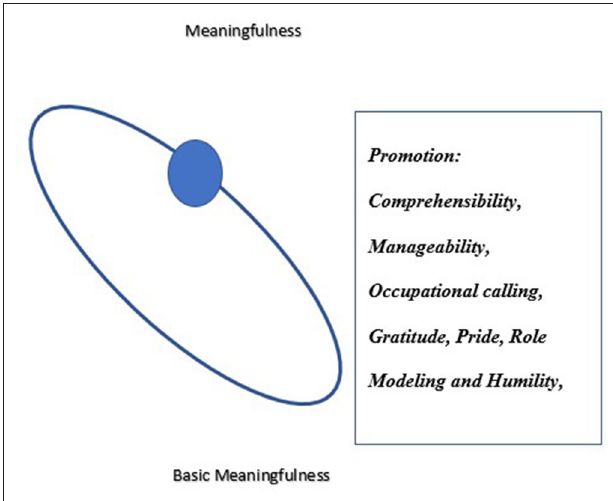
FIGURE 3 | The dynamic sphere of resilience on the meaningfulness